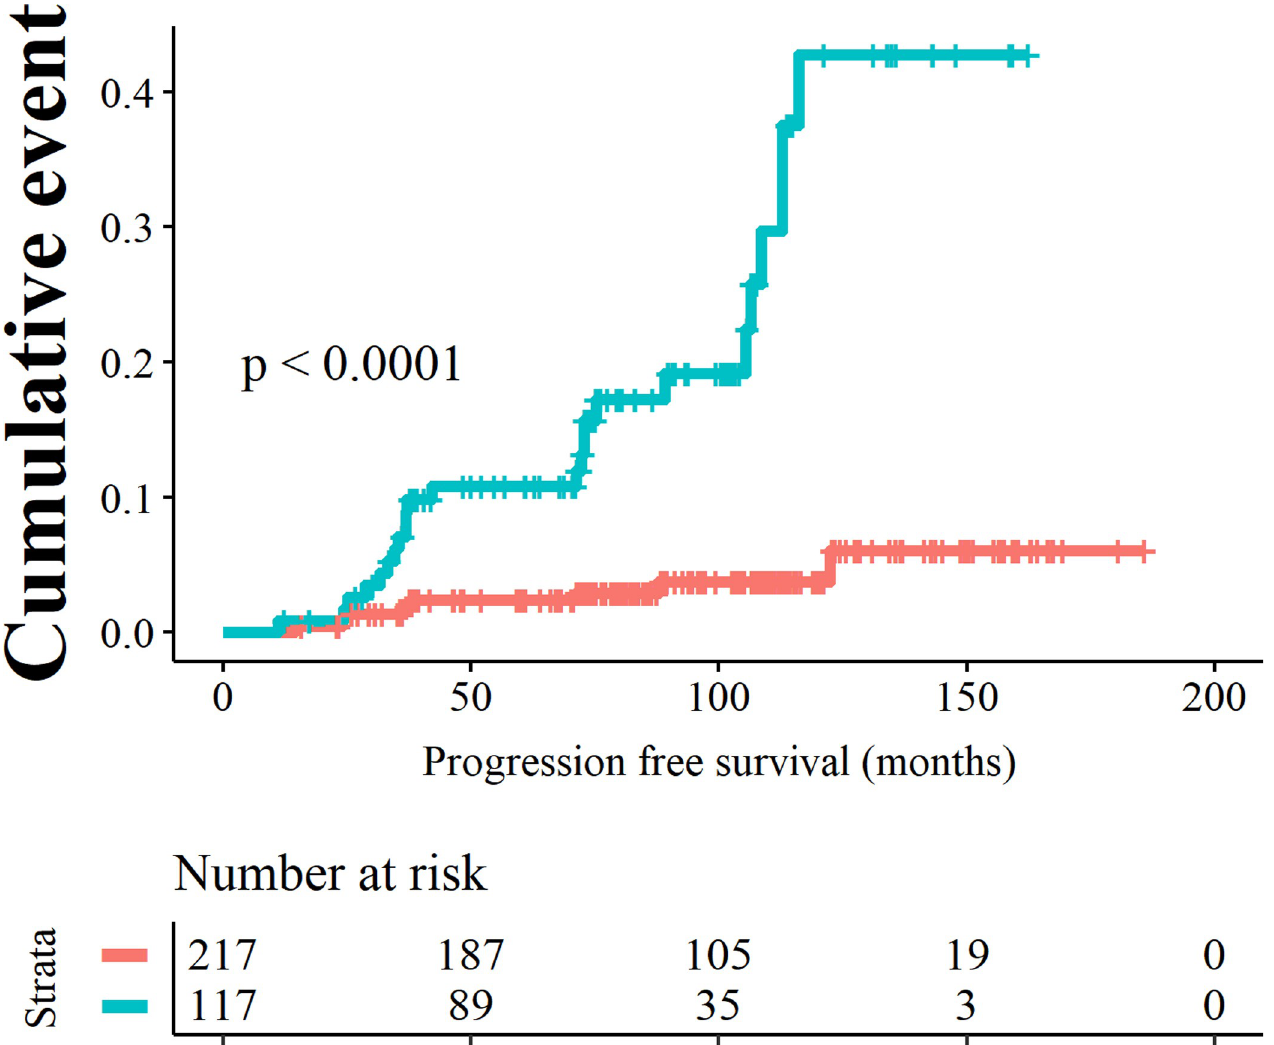
Fig 5. Kaplan Meier curves showing progression to HGD/EAC resulting from binary cut offs of the risk score at 12.6. Patients with a low risk score are depicted by the orange curves, patients with high risk scores are depicted by the blue curves.